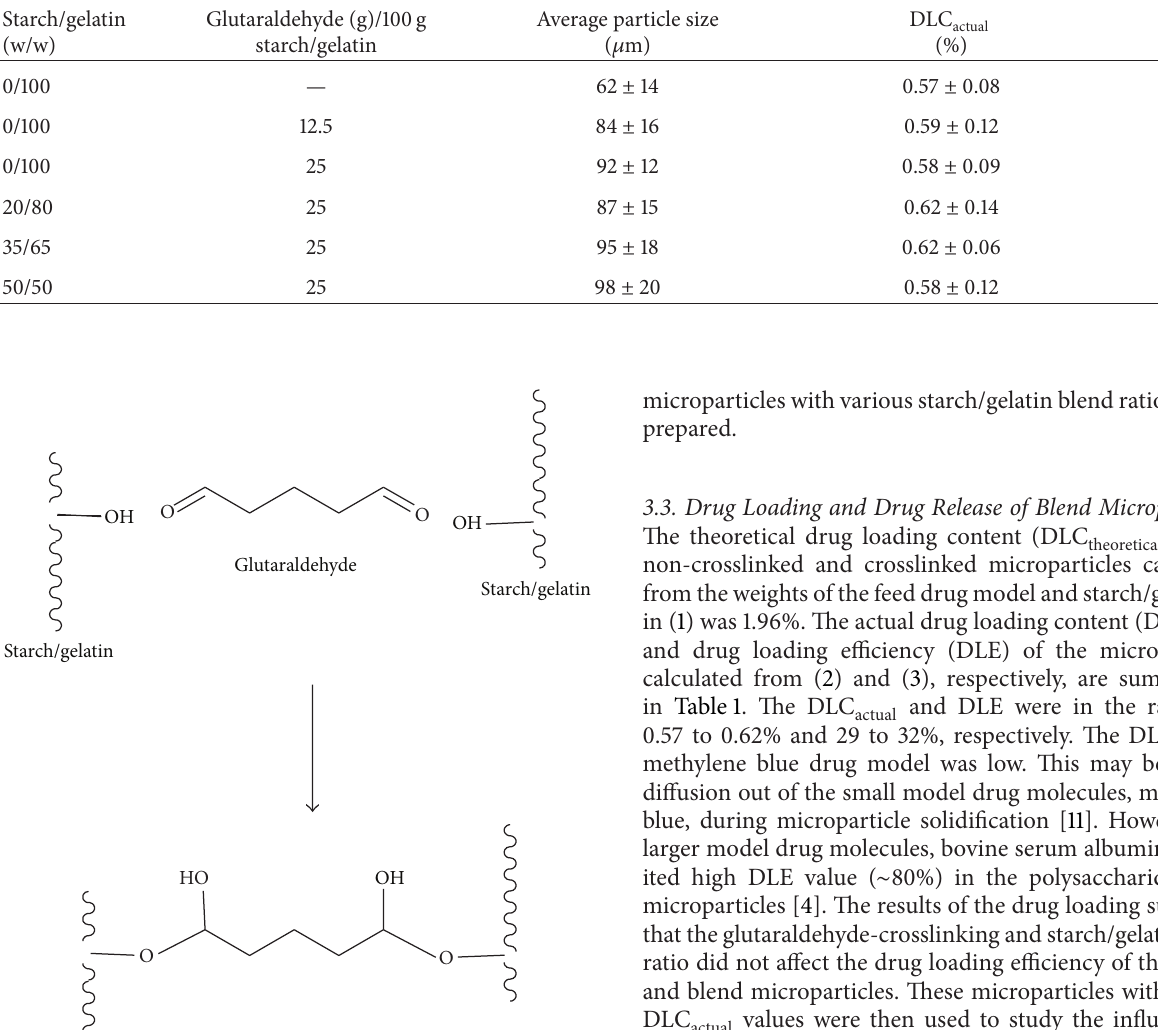
Table 1: Average particle size and drug loading of starch/gelatin blend microparticles.